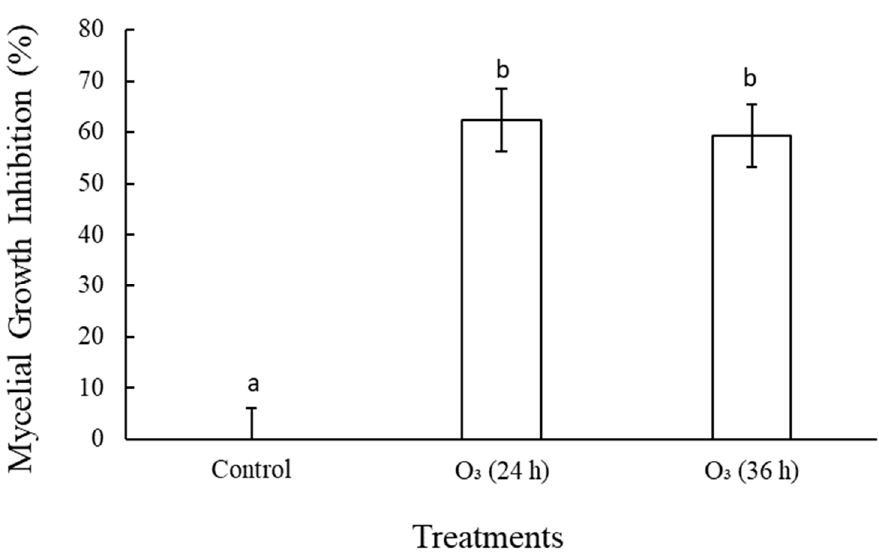
Figure 1. Effect of gaseous ozone (0.25 mg/L) on mycelial growth inhibition (%) of L. theobromae incubated at 10 °C for fourteen days and seven days at 25 °C ( p < 0.05; least significance difference = 12.27; n = 9). Bars with the same letter are not significantly different ( p < 0.05).